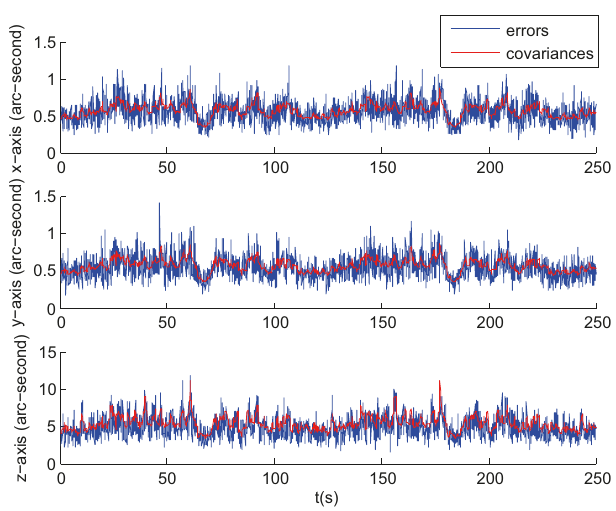
Figure 11. Root mean square estimation error and square root of the error covariance from the Kalman filter for attitude estimation.